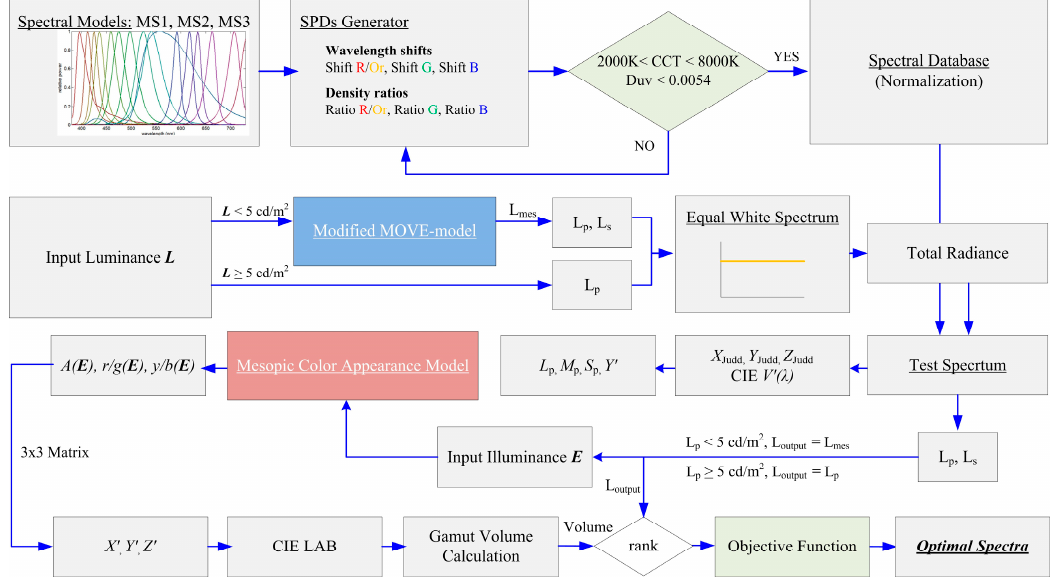
Figure 1. Flow chart of white LED spectrum optimization.